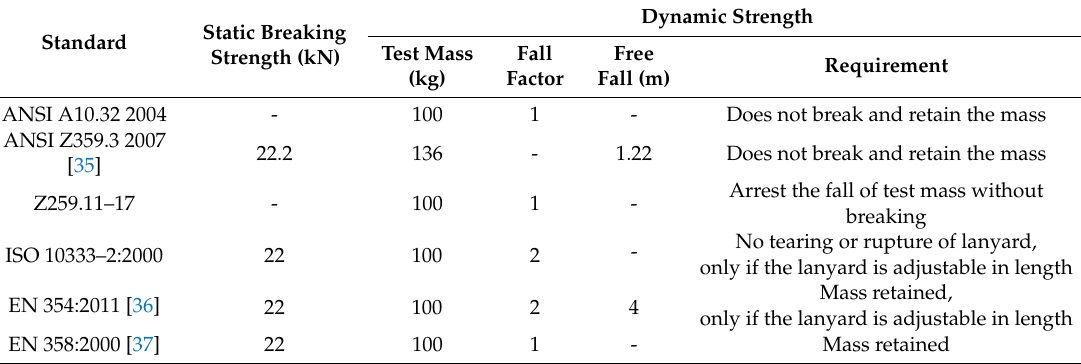
Table 2. Static breaking strength of lanyards according to di ff erent